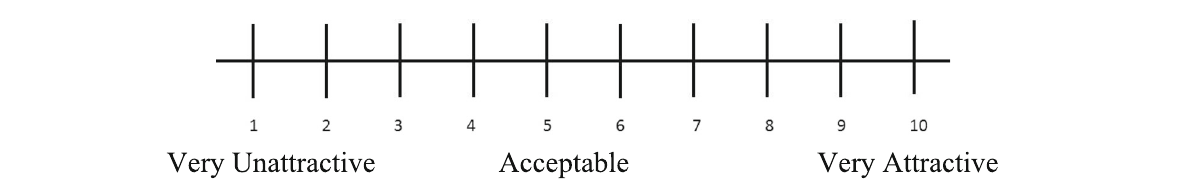
Fig. 1 Assessment scale used by raters to evaluate facial aesthetics after repair